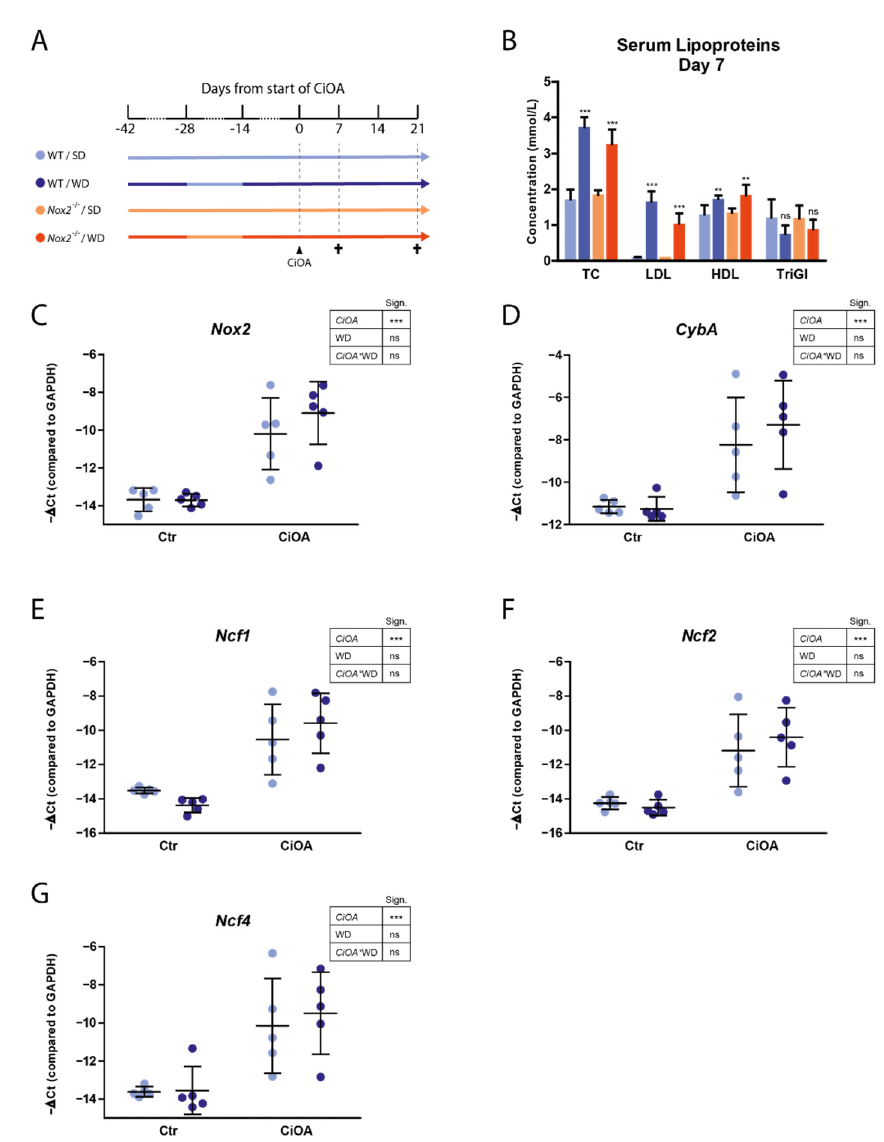
Figure 2. WD-feeding increases serum LDL levels and CiOA induction increases expression of NOX2-complex genes in mouse synovium. ( A ) Schematic of experiment design. C57Bl/6 and Nox2 − / − mice were fed either a standard diet (SD) or western diet (WD). Mice were sacrificed on day 7 and 21 of CiOA. n = 6 per group for day 7 and n = 10 per group for day 21. ( B ) Serum concentrations of total cholesterol (TC), low-density lipoprotein (LDL), high-density lipoprotein (HDL) and triglycerides (TriGl) were determined at day 7 of CiOA ( n = 6). Significance levels show results of WD versus SD in each genotype separately. ( C – G ) mRNA expression of NOX2-complex genes Nox2 , Cyba , Ncf1 , Ncf2 and Ncf4 is increased in CiOA knee joints compared to contralateral control knee joints at day 7 of CiOA ( n = 5). Data are presented as mean and SD ( B ) or mean and 95% CI ( C – G ). p -value summary resulting from two-way ANOVA shown in tables: ***, p < 0.001; **, p < 0.01; ns, p >